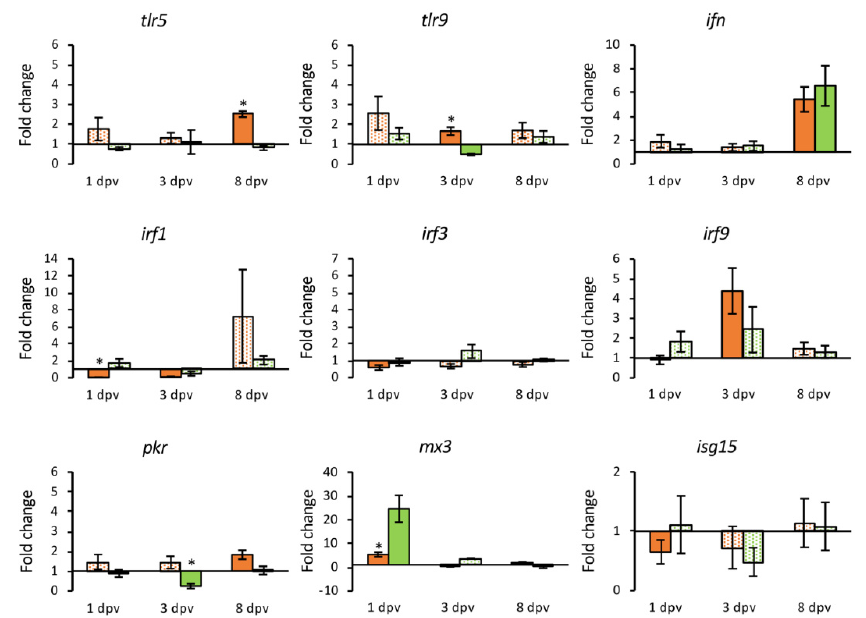
Figure 7. Relative expression levels (2 −ΔΔ Ct ) of TLR-coding genes and type I interferon related genes in the intestine from vaccinated (orange) and mock-vaccinated (green) fish at different times post-vaccination (dpv). Differentially expressed genes (DGEs) are represented in solid color. Data are expressed as mean ± SEM (n = 5). Significant differences are indicated by an asterisk ( p < 0.05).